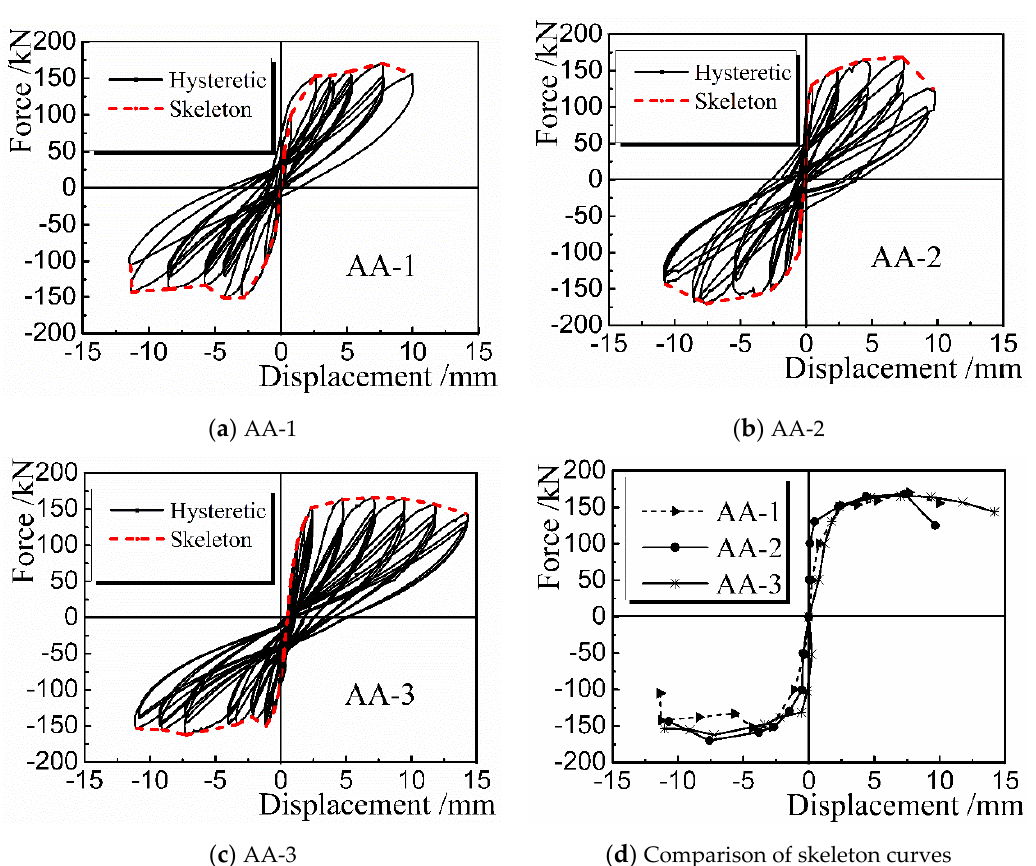
Figure 7. Hysteresis and skeleton curves.